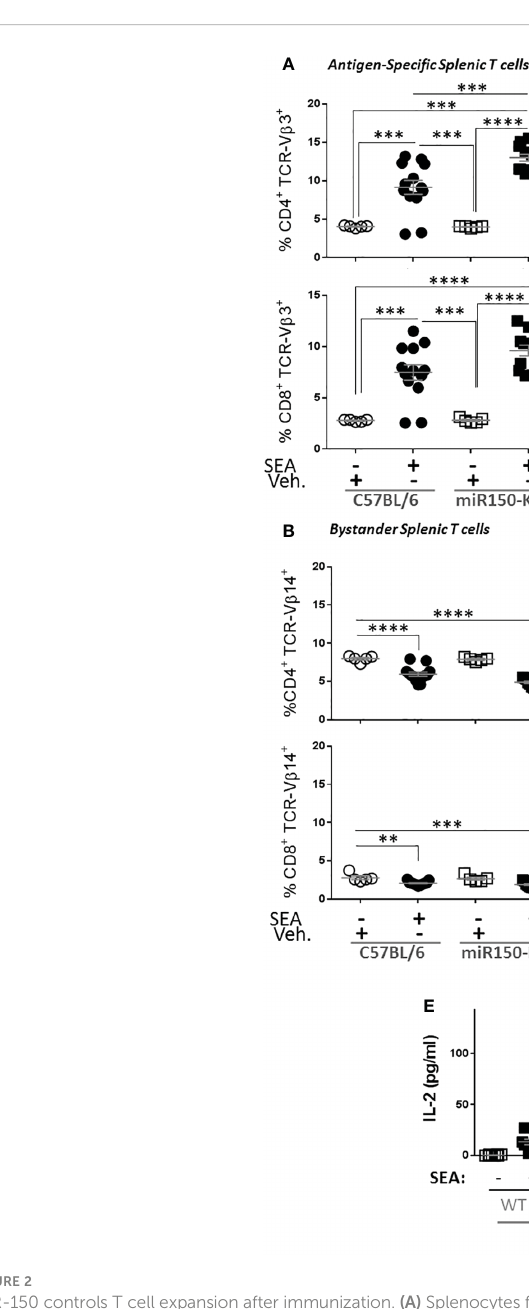
per cell basis using congenic markers to identify cell populations in the co-culture (Figure 3B). This method was developed to enable comparison of proportional contribution of antigen-responding cells from different tissues under identical stimulation condition. Flow analysis showed that activated CD4 + T cells from the lymph nodes and spleen expressing IL-2 were, respectively, 1.5 and 2 times